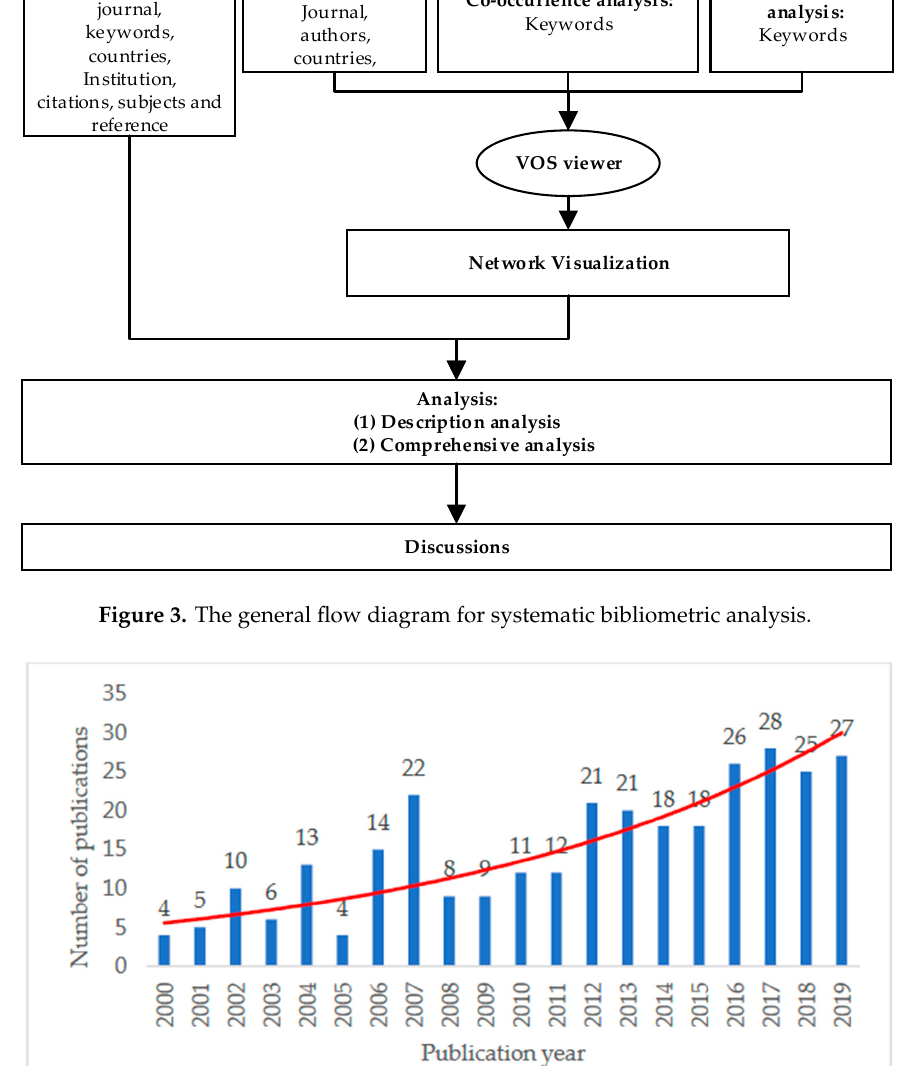
Figure 4. The number of annual publications between 2000 and 2019.